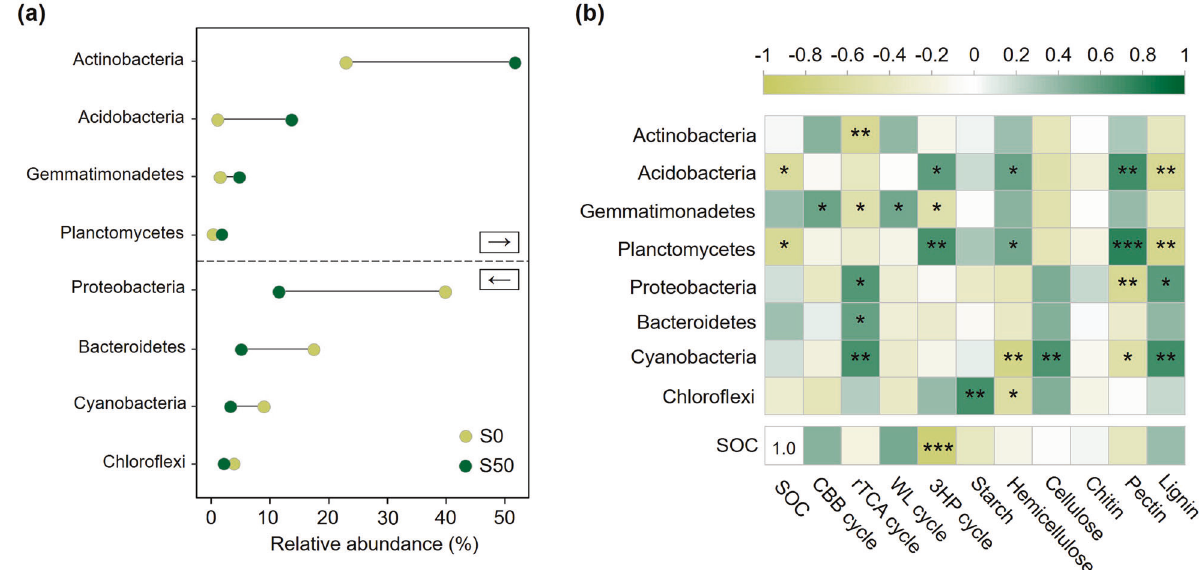
Fig. 4 Relative abundance of major bacterial phyla and the relationships among retreat time, bacterial phyla, and functional gene groups in the glacier foreland of Laohugou Glacier No. 12. a Change of relative abundance of major bacterial phyla during 50 years of receding; ( b ) Pearson coef fi cients among soil organic carbon (SOC), relative abundance of bacterial phyla, and proportion of functional gene groups in carbon degradation and carbon fi xation. Numbers in the fi ve sampling sites represent the retreat years (S0, S10, S15, S31, and S50). The cycle of CBB, rTCA, WL, and 3HP represent the reductive pentose phosphate cycle, reductive tricarboxylic acid cycle, reductive acetyl-CoA pathway, and 3-hydroxypropionate bicycle carbon fi xation pathways, respectively. Directions of arrows indicate the increase (pointing to the right) and decrease (pointing to the left) of relative abundance. “ *, ” “ **, ” and “ *** ” indicate the signi fi cant differences of p < 0.05, 0.01, and 0.001, respectively. Green shading indicates a higher correlation, whereas yellow shading indicates a lower correlation.